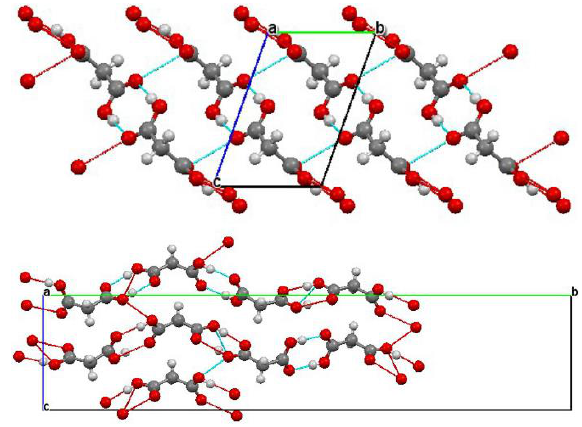
Figure 2. Lattice projection of malonic acid crystals